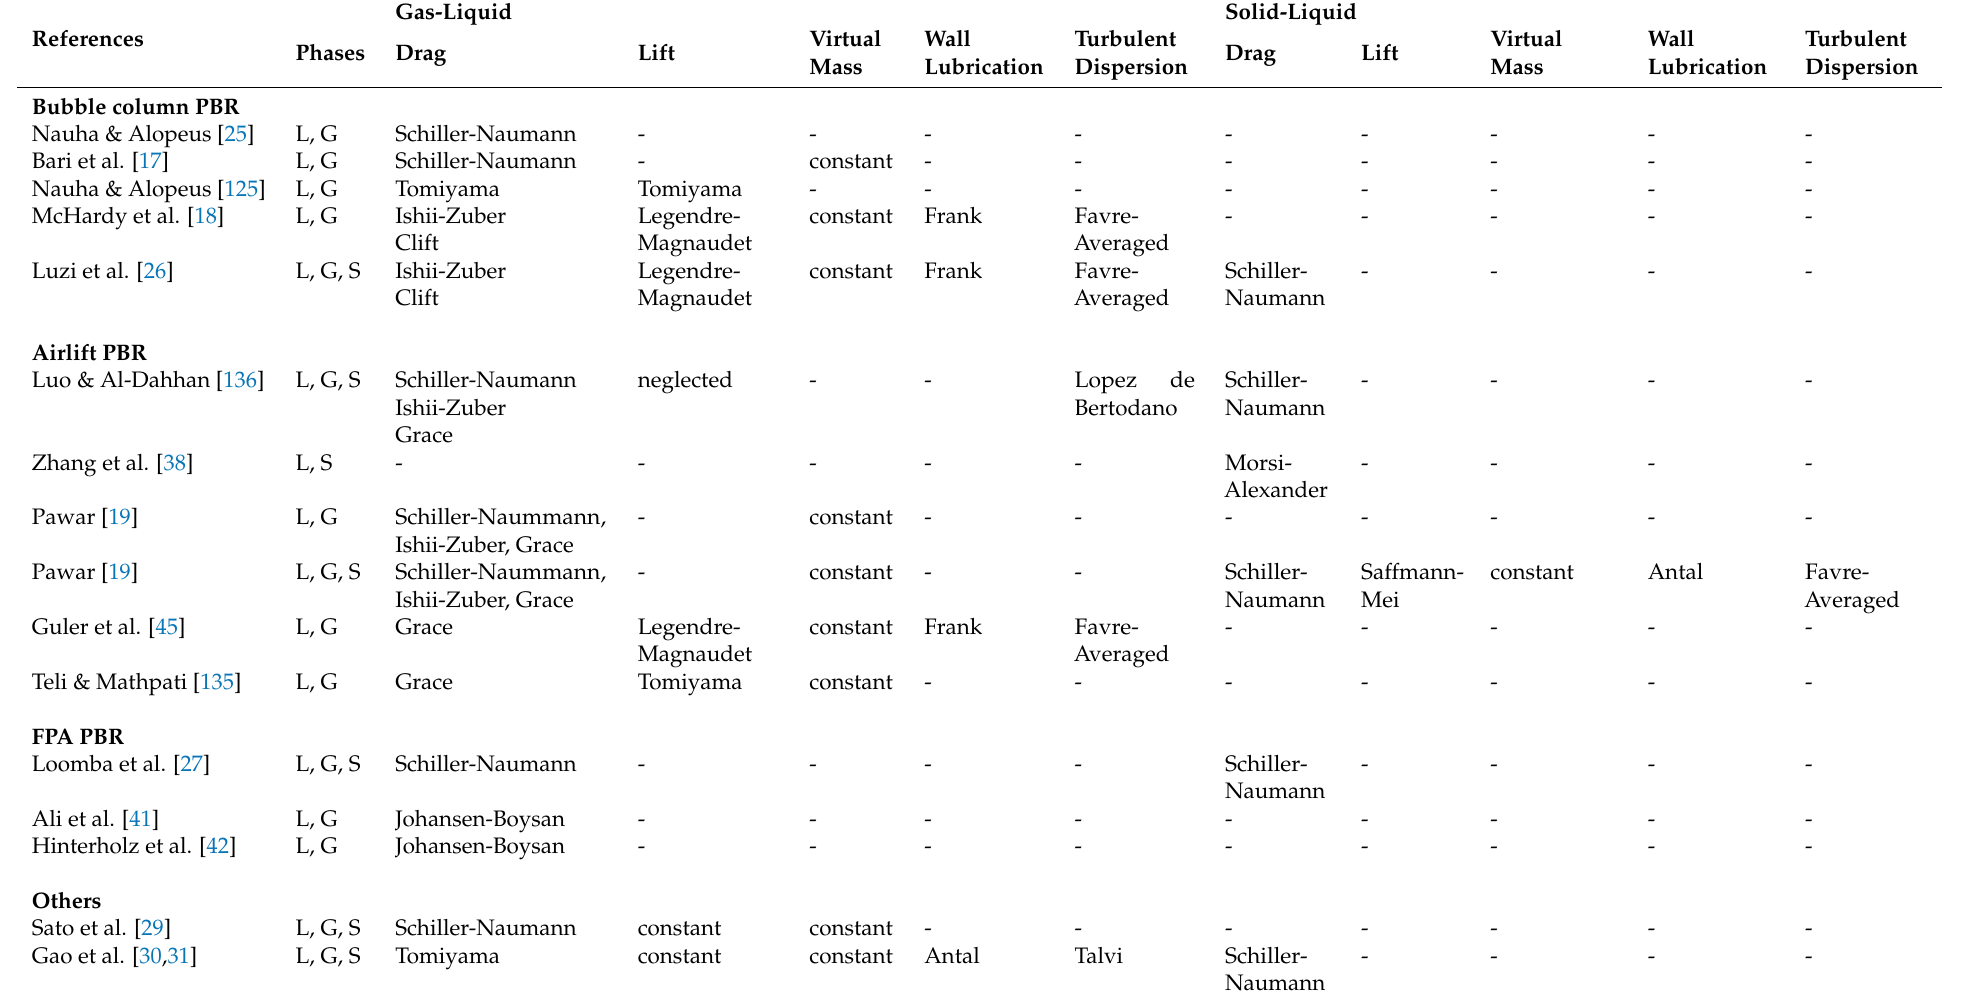
Table 2. Overview of interphase momentum exchange models used for modeling multiphase